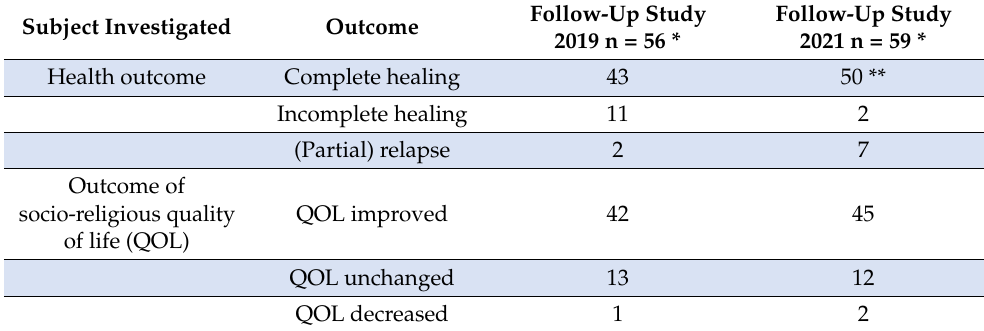
Table 14. Health outcome and socio-religious quality of life (QOL).